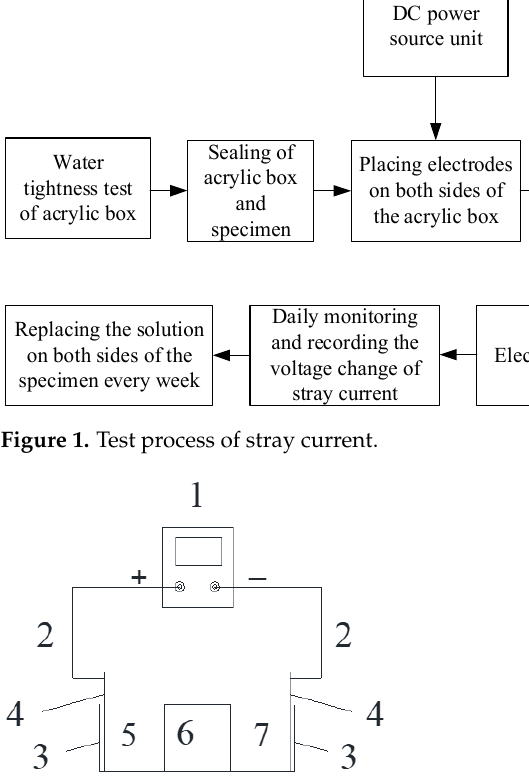
Figure 2. Schematic of stray current device.